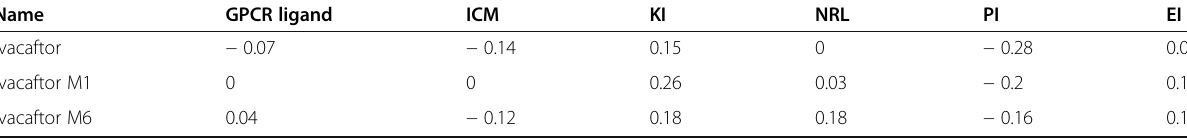
Table 15 Bioactivities of Ivacaftor and its metabolites based on the drug likeness score were calculated using Molinspiration tool